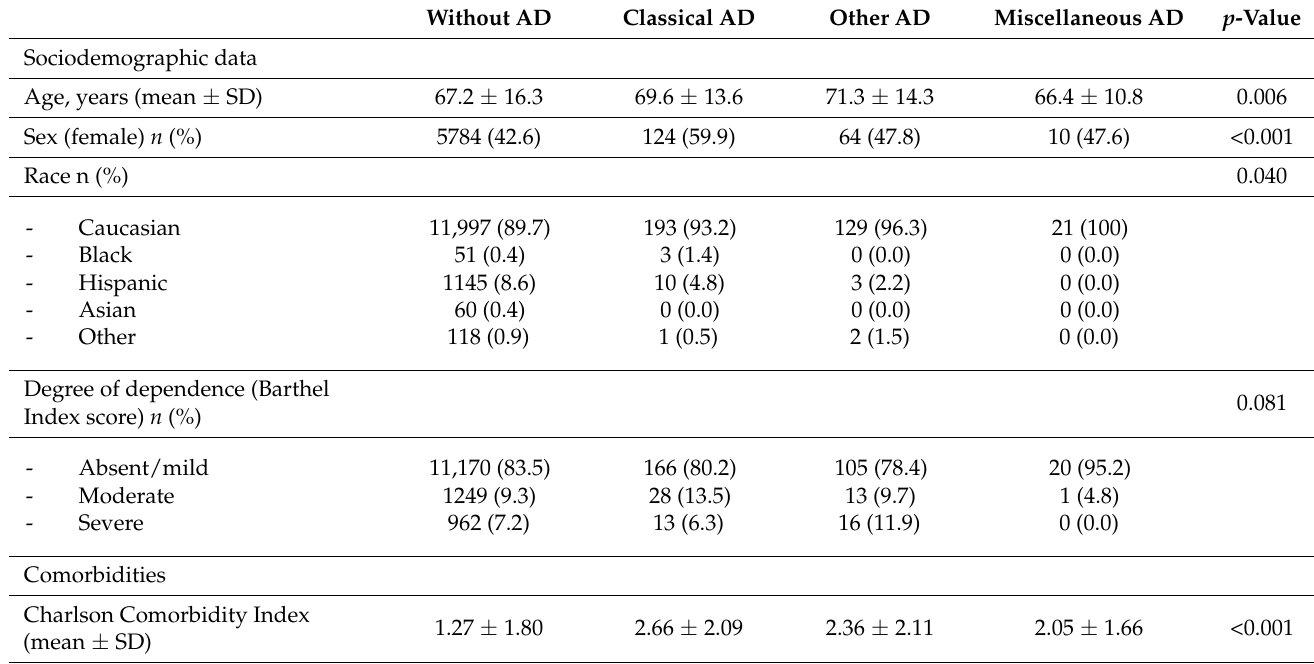
Table 2. Baseline characteristics among